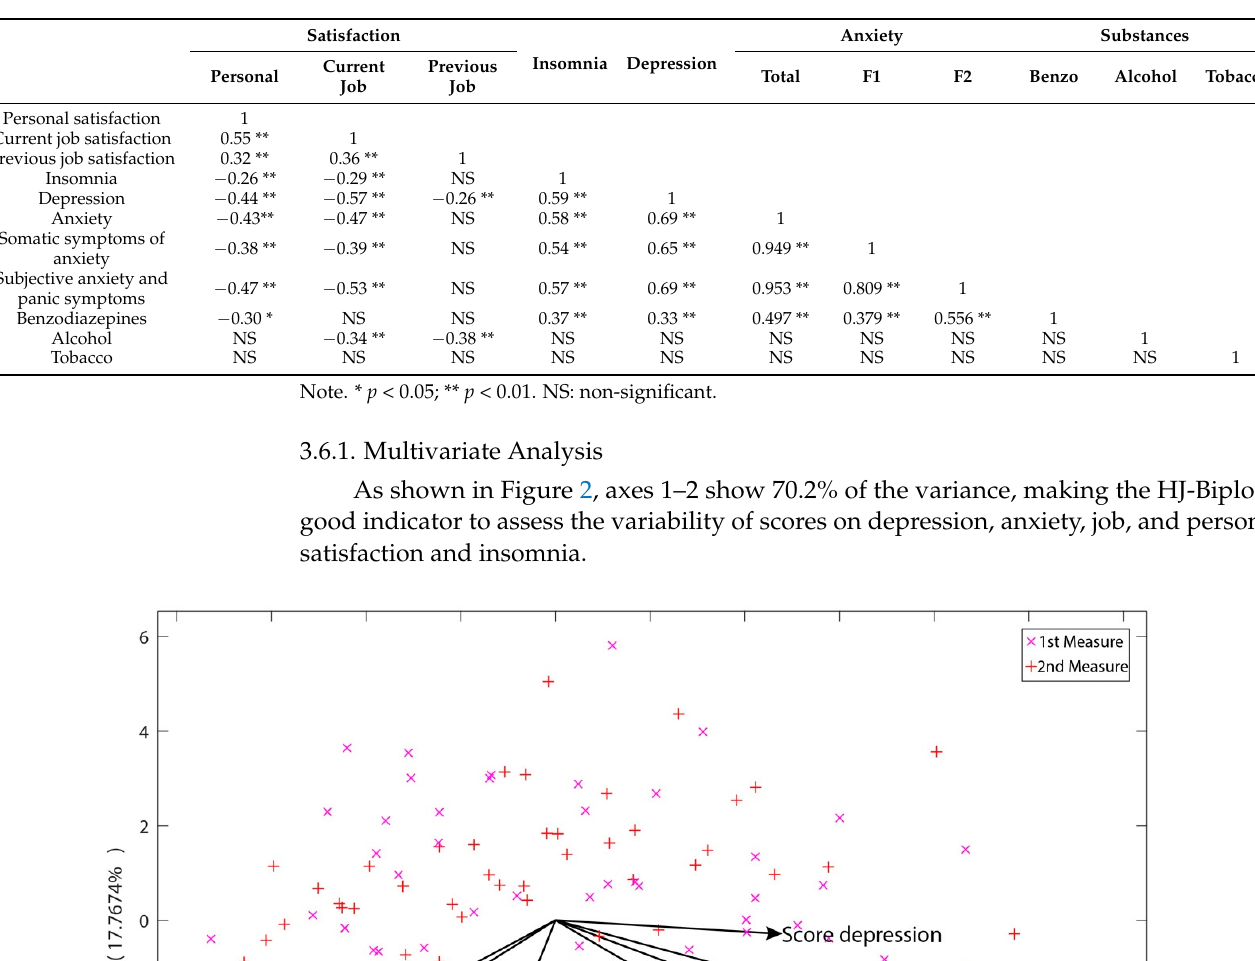
Table 11. Bivariate correlations using Pearson’s correlation coefficient.